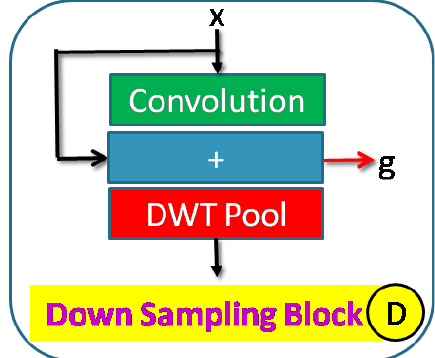
Figure 3. Structure of down–sampling block.